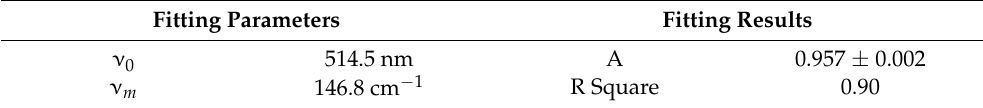
Table 3. Fitting parameters and